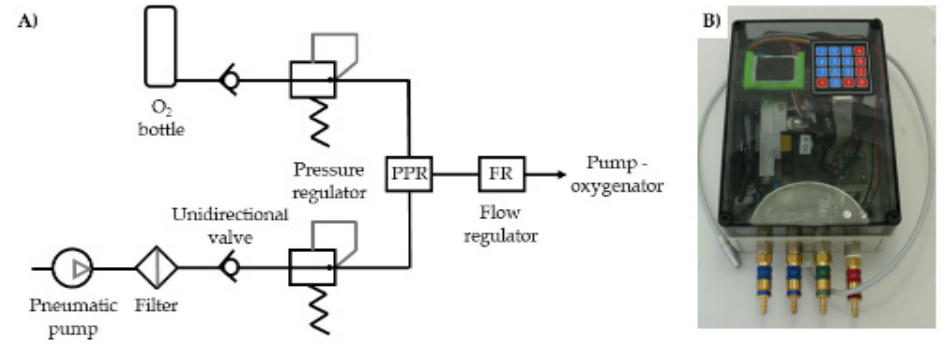
Figure 4. ( A ) gas blender schematic and ( B ) gas blender prototype.